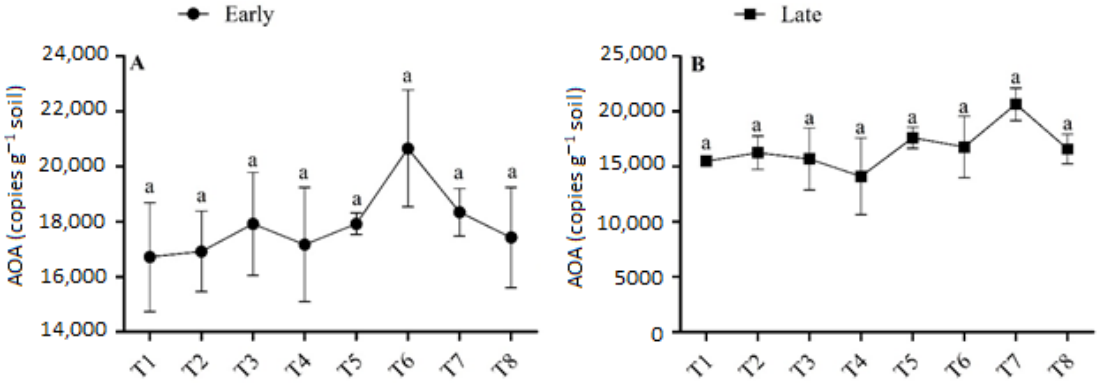
Figure 5. ( A , B ) Concentration of AOA in the early and late season under high ‐ and low ‐ dose urea application and different levels of biochar application. Note: Bars with different letters are significantly different, at p < 0.05.